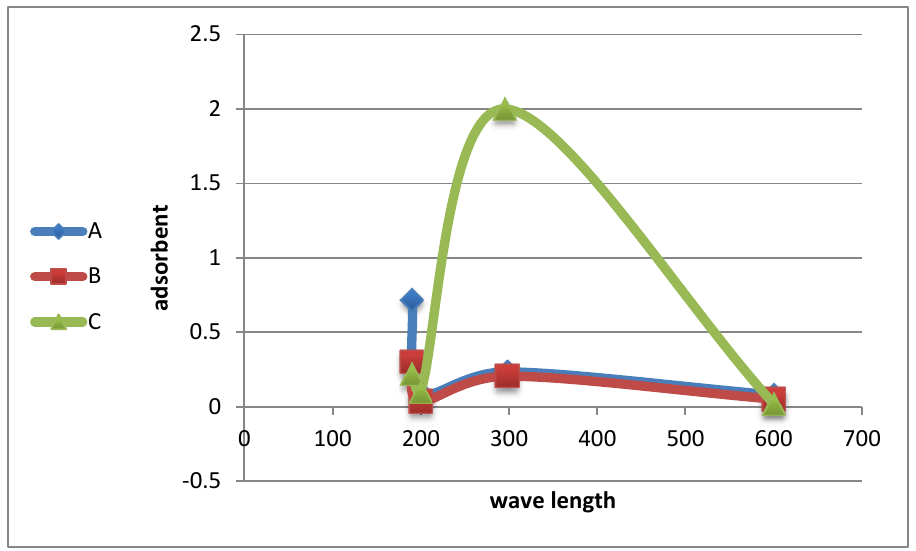
Fig. 17. Proof the order of reaction to the adsorption of Albumin A mono monomer, B di monomer tri monomer.